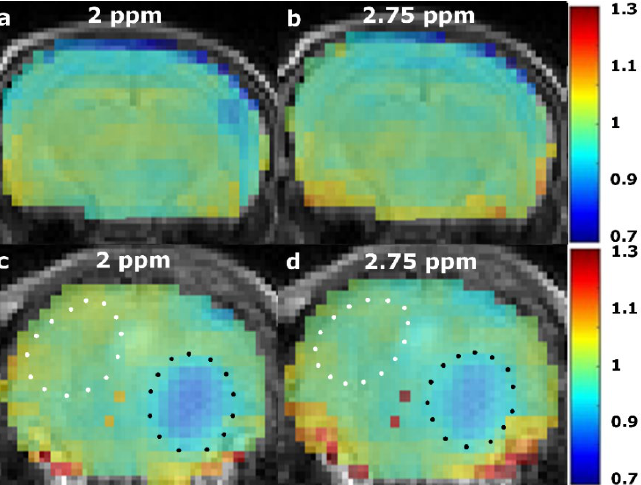
Figure 4. Normalized AACID maps obtained in a single healthy NU/NU mouse brain using the 2 ppm amine resonance ( a ), compared to the 2.75 ppm ( b ) amine resonance. Normalized AACID map of a NU/NU mouse with a brain tumor using the 2 ppm amine resonance ( c ), compared to the 2.75 ppm ( d ) amine resonance. Typical manually defined ROIs are shown on the contralateral side (white dotted line), and over the tumor (black dotted line).